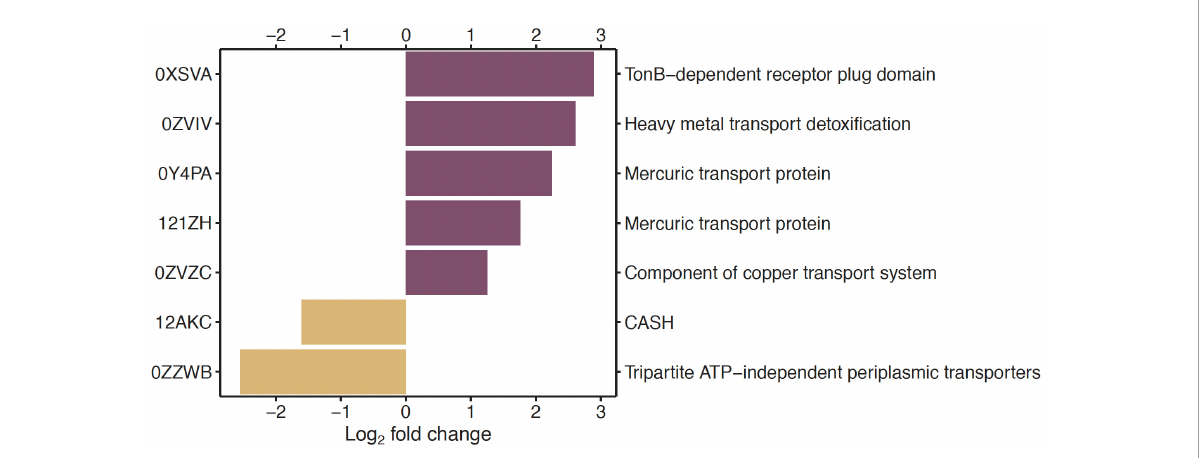
FIGURE2 Under- and overrepresented genes in the pairwise comparison of low vs. high Hg contamination level, for genes annotated against the EggNOG database in the functional category of inorganic ion transport and metabolism (P). On the left side are the gene identification numbers, and on the right side are the corresponding functional genes. Only significantly ( P < 0.01) differentially abundant genes between the two Hg contamination levels whose log 2 -fold change was lower than –1 or higher than +1 are